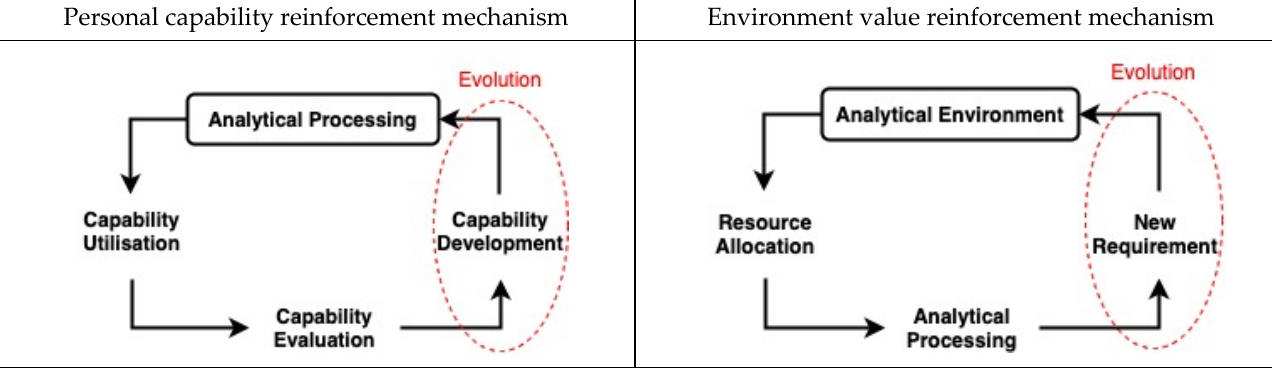
Figure 3. Reinforcement mechanisms in SSA environment.